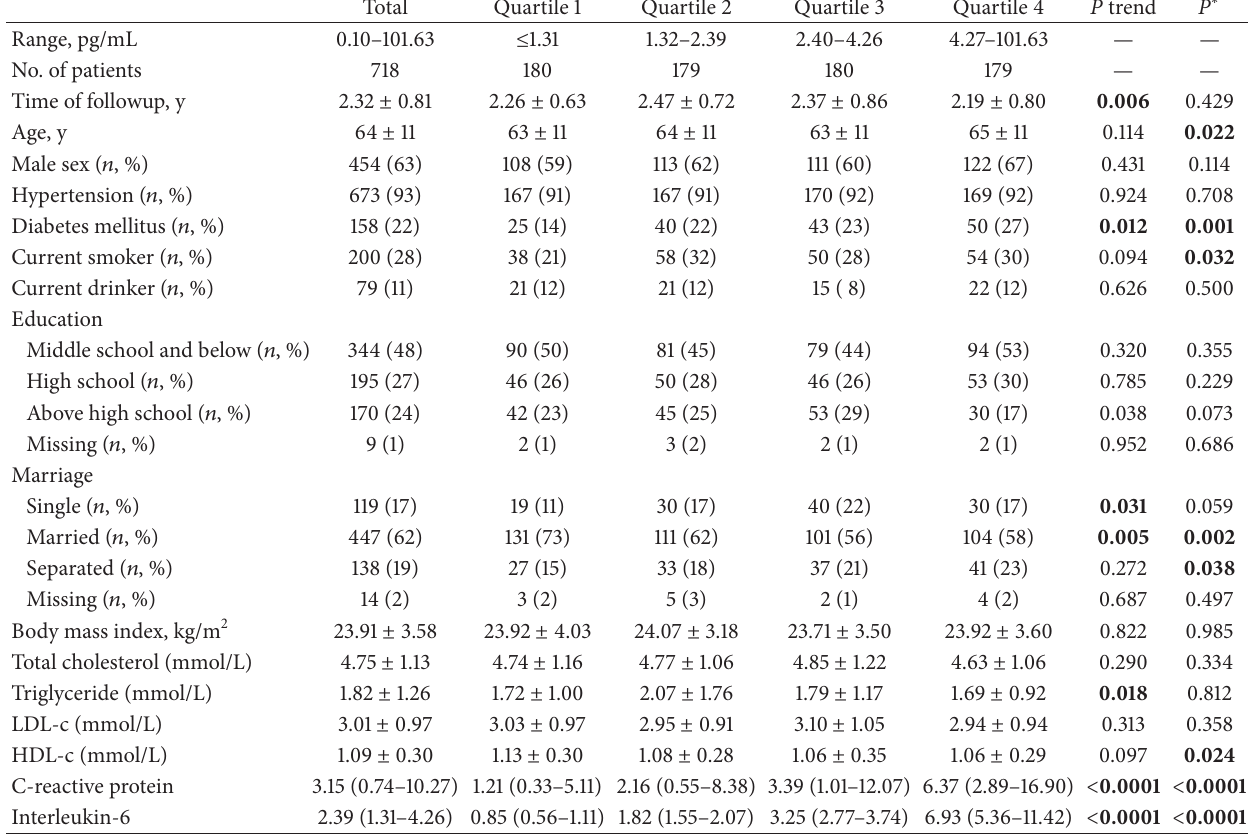
Table 1: Baseline clinical characteristics according to total and quartiles of serum